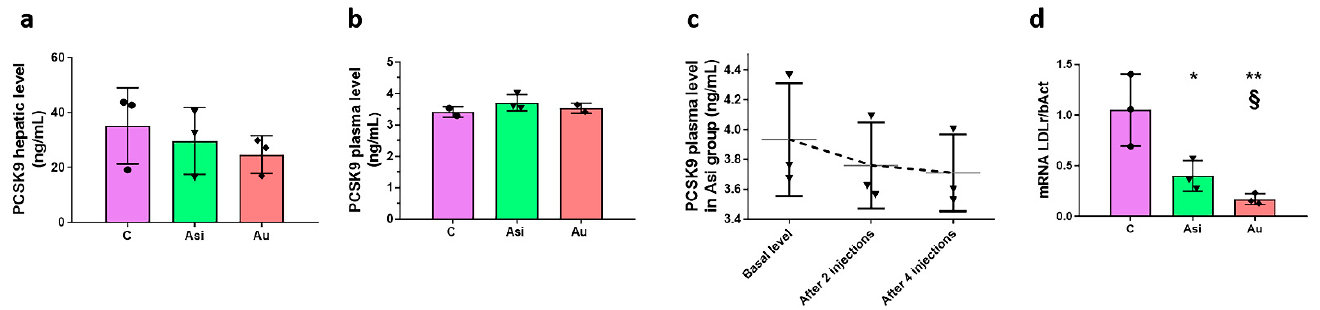
Figure 3. PCSK9 treatment evaluation in the liver ( a ) and plasma ( b ) harvested after animals’ euthanasia. Evolution of PCSK9 level in the plasma of animals receiving statin and PCSK9 siRNA treatment ( c ). The direct target of PCSK9, the hepatic receptor for LDL (LDLr) was also evaluated after a high-fat diet and hypolipidemic treatment ( d ). The statistical significance over C samples is represented by * (* p < 0.05, ** p < 0.01), while the one over Asi is visible with § (§ p < 0.05).